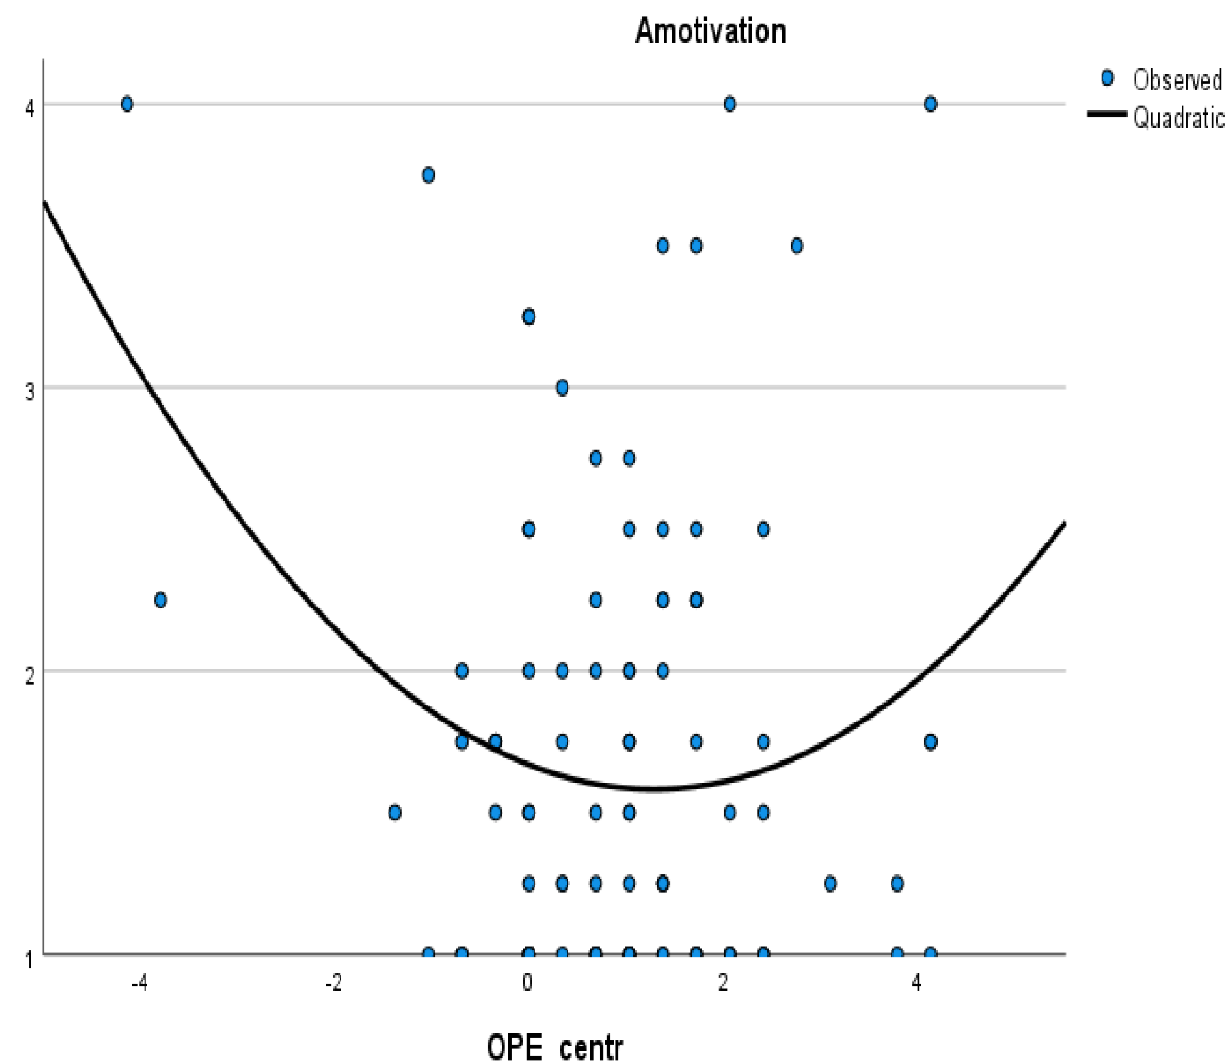
Figure 1. Graphical presentation of the quadratic association between overplacement (difference between self-assessment of own infection prevention and control (IPC) competencies and the compe- tencies of the colleagues of the same profession) and amotivation. Note: OPE_centr-Overplacement is a centered variable (weighted through the scale mean value).